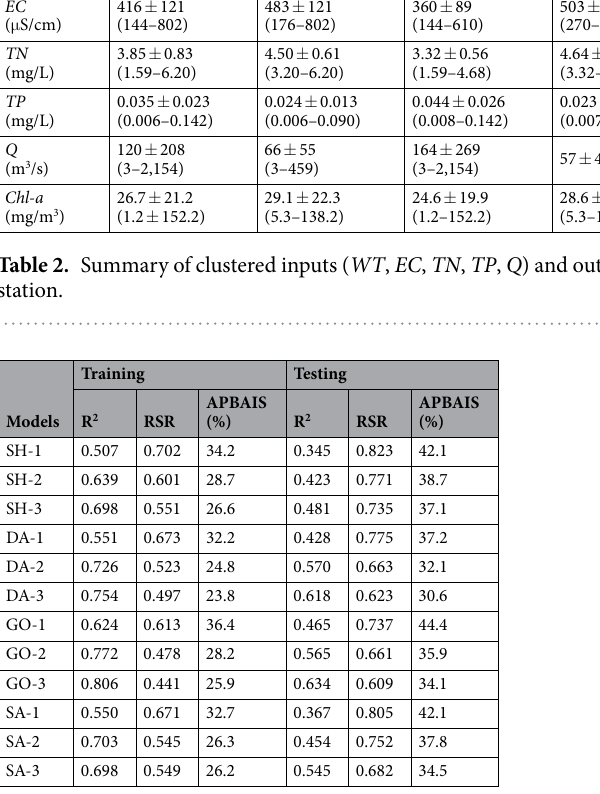
Table 3. Prediction accuracy of ANN models with different numbers of